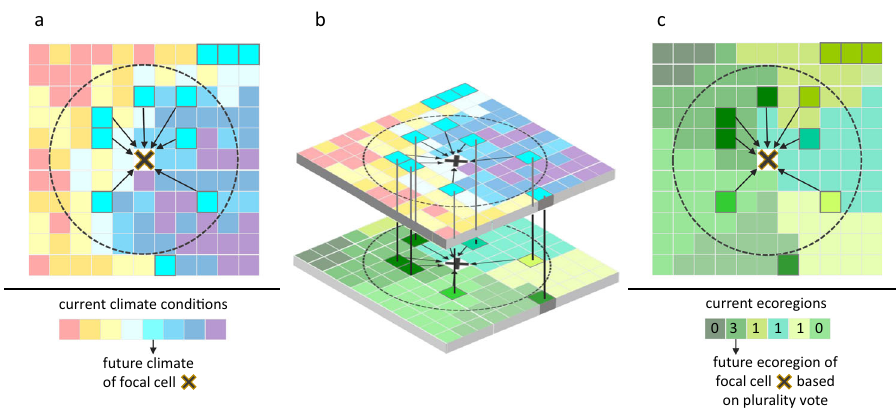
Fig. 1 Modeling climate change impacts on conservation planning units using spatial climate analogs. Under current conditions ( a ), reverse analogs (sites that have climates that are similar to those projected in the future for a focal cell) were identi fi ed within a fi xed search radius (dotted line) (adapted from ref. 83 ). Reverse analogs were then used in conjunction with a map of terrestrial ecoregions ( b ) to project potential changes in ecoregions and biomes. In this study we assess compositional changes at focal sites based on a plurality vote from 100 analog sites ( c ).